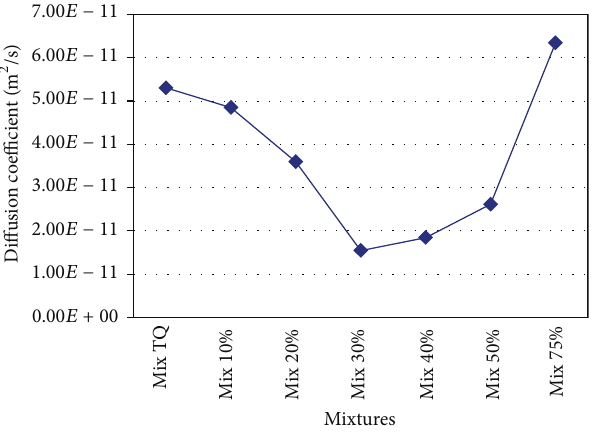
Figure 17: Chloride ion diffusion coefficient for rubber cement